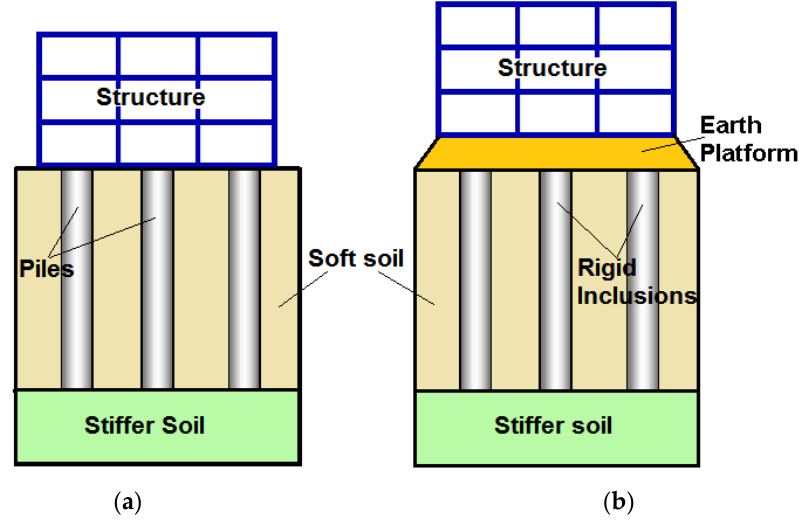
Figure 1. Vertical reinforcement systems. ( a ) Soil–Pile–Structure; ( b ) Soil–Inclusion–Platform-Structure.